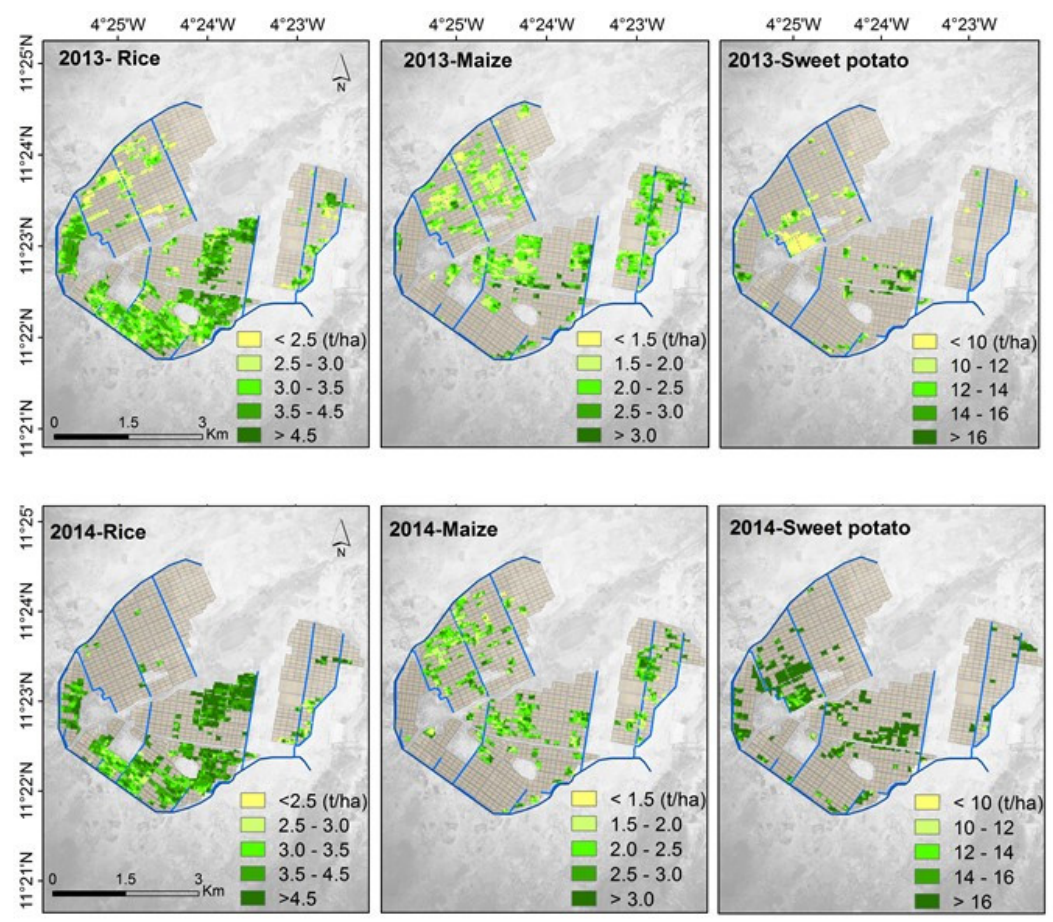
Figure 7. Estimated yields for rice, maize, and sweet potato plots across the Kou Valley irrigation scheme during the dry season production period in 2013 and 2014.